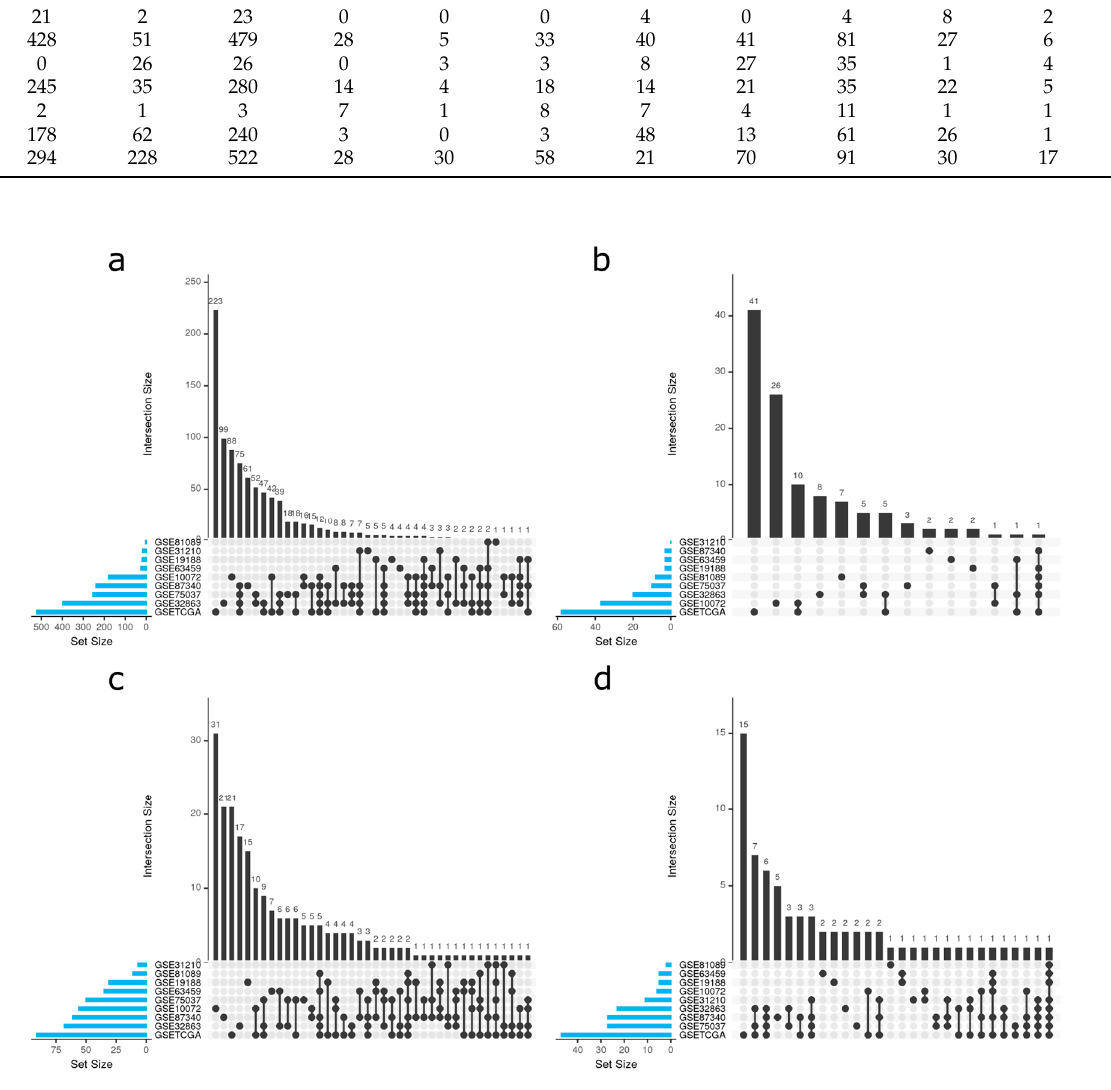
Figure 3. The intersection of significant functions between studies. UpSet plots for ( a ) Gene Ontology (GO) biological process, ( b ) GO molecular functions, ( c ) GO cellular components, and ( d ) Kyoto Encyclopedia of Genes and Genomes (KEGG) pathways. UpSet plots detailing the number of common elements among GO terms in our functional enrichment analysis. Horizontal bars indicate the number of significant elements in each study. The vertical bars indicate the common elements in the sets, indicated with dots under each bar. The single points represent the number of unique elements in each group.